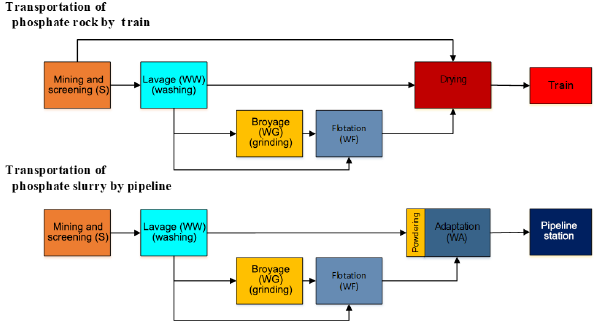
Figure 3. The functional processes and flows of products in Khouribga (mining area) by transportation